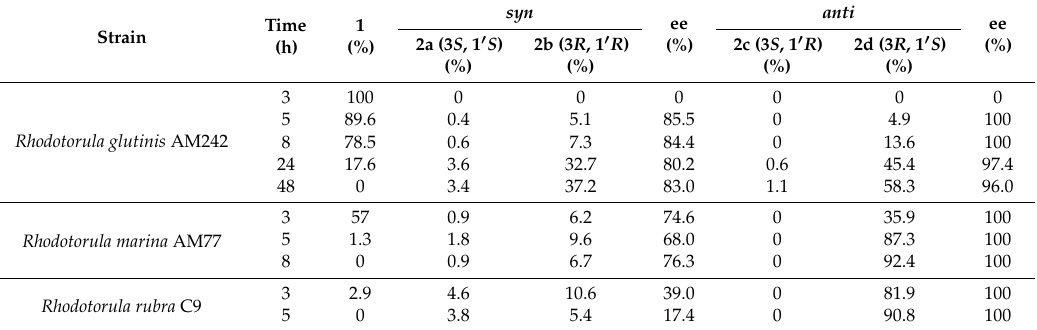
Table 6. The results of biotransformation of α -acetylbutyrolactone 1 in buffer solution with 1% glucose (in % according to GC (chiral